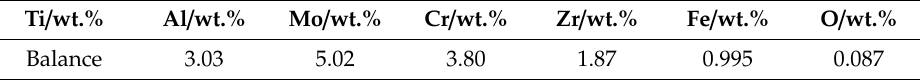
Table 1. Actual chemical composition of the Ti-35421 alloy by titration. Ti / wt.% Al / wt.% Mo /